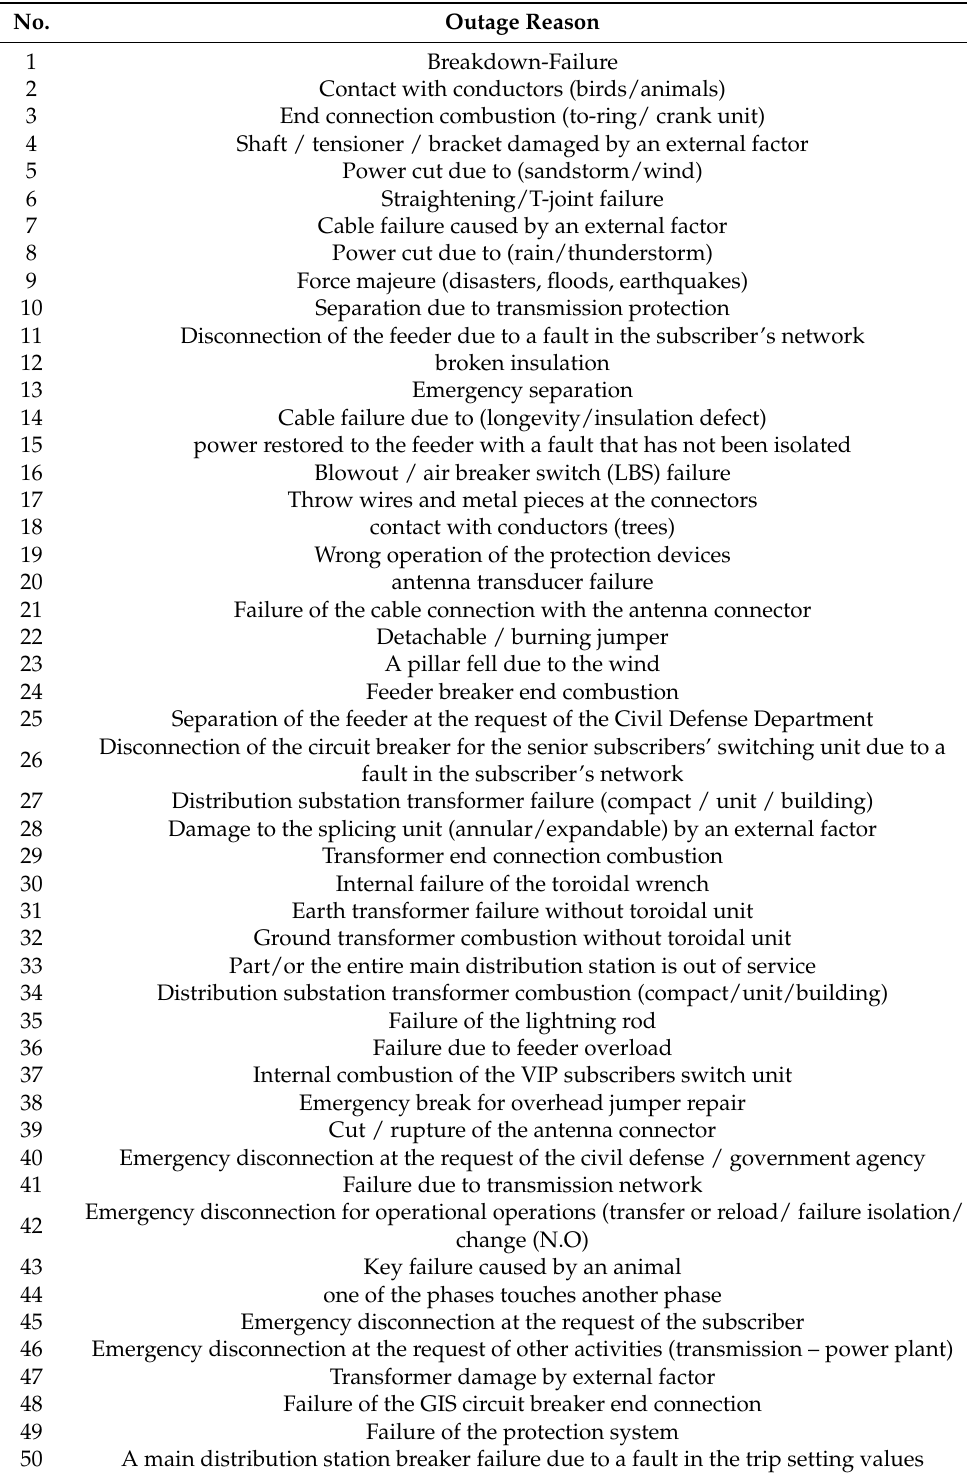
Table 1. Types of faults occurred during the period of